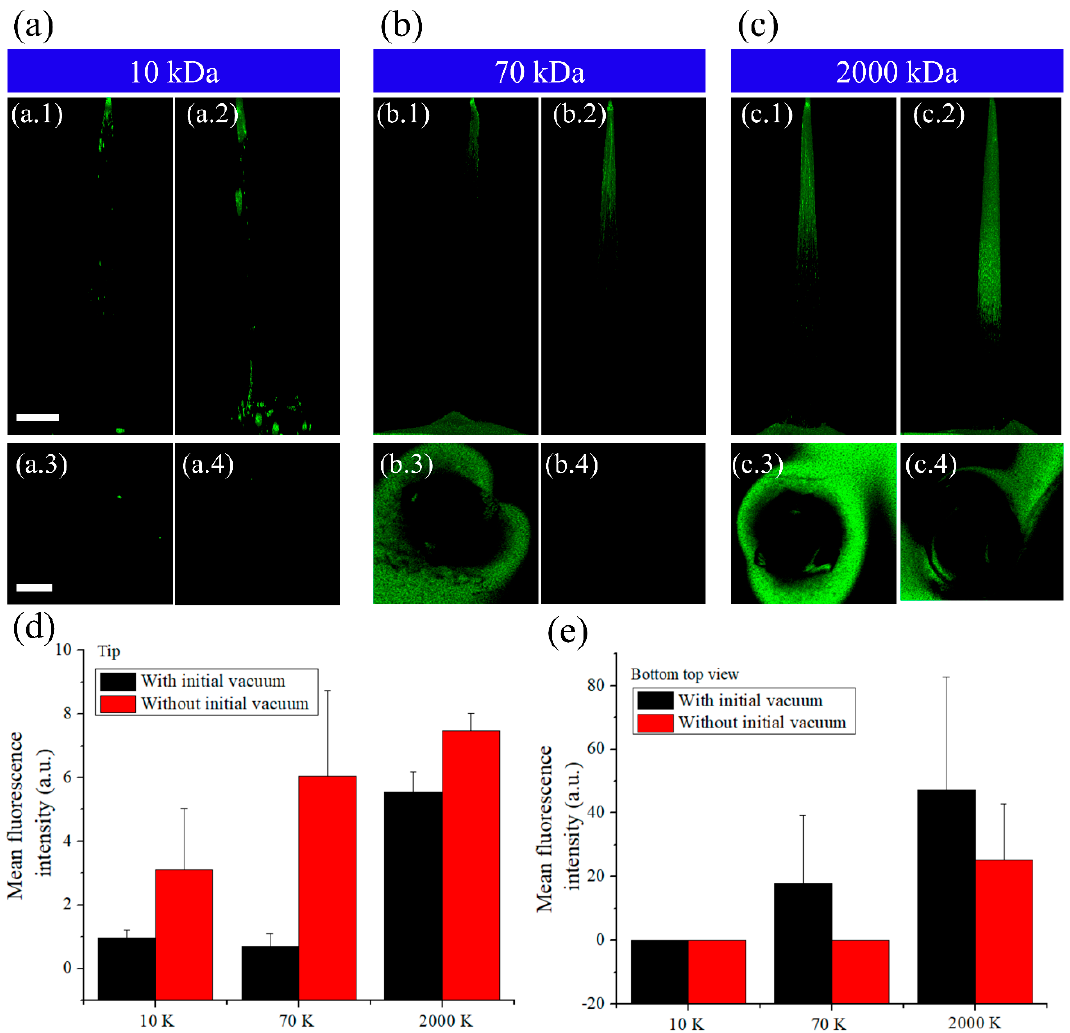
Figure 3. Confocal fluorescence images stacked along the z-axis of microneedles fabricated with (1,3) or without (2,4) initial vacuum, loaded with ( a ) 10 kDa FITC-dextran, ( b ) 70 kDa FITC-dextran, or ( c ) 2000 kDa FITC-dextran. The average fluorescence intensity of FITC-dextrans of di ff erent molecular weights ( d ) in the needle tip and ( e ) at the bottom (top view) (scale bar: 100 µ m). The error bars represent mean ± standard deviation ( n =